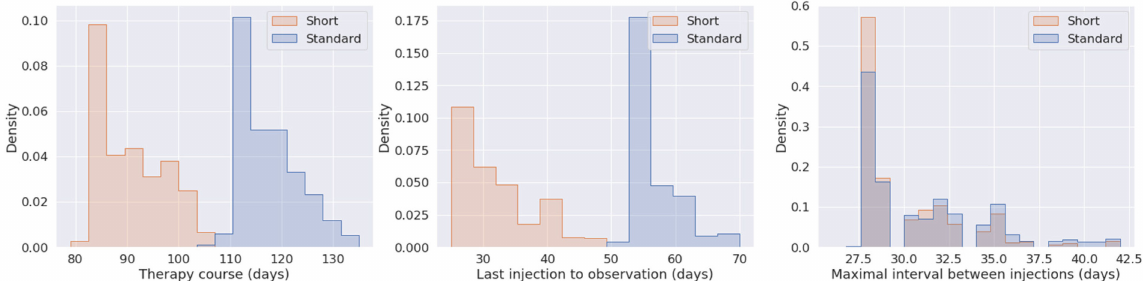
Figure 2. Temporal differences between eyes undergoing standard versus short protocol. Density shown on the x-axis refers to total count of eyes normalised to